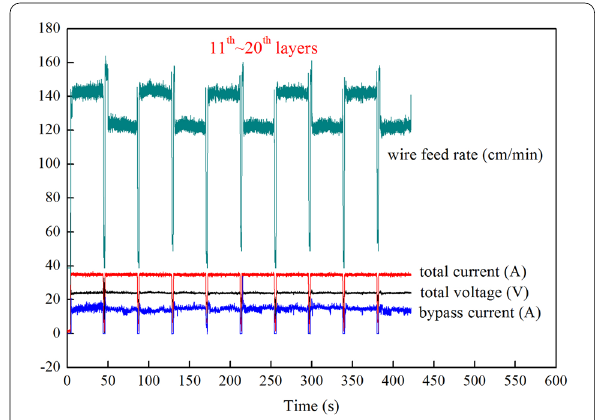
Figure 22 Parameters data collected in the deposition process of the 11th ‒ 20th